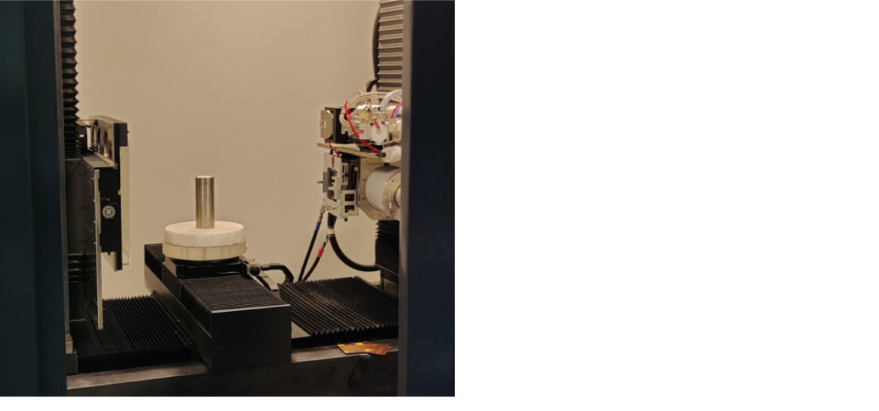
Figure 8. The industrial X-ray inspection equipment from Deepsea Precision Co., Ltd. Table 6. The basic configuration of the core imaging chain components from the X-ray inspection equipment of Figure 8.